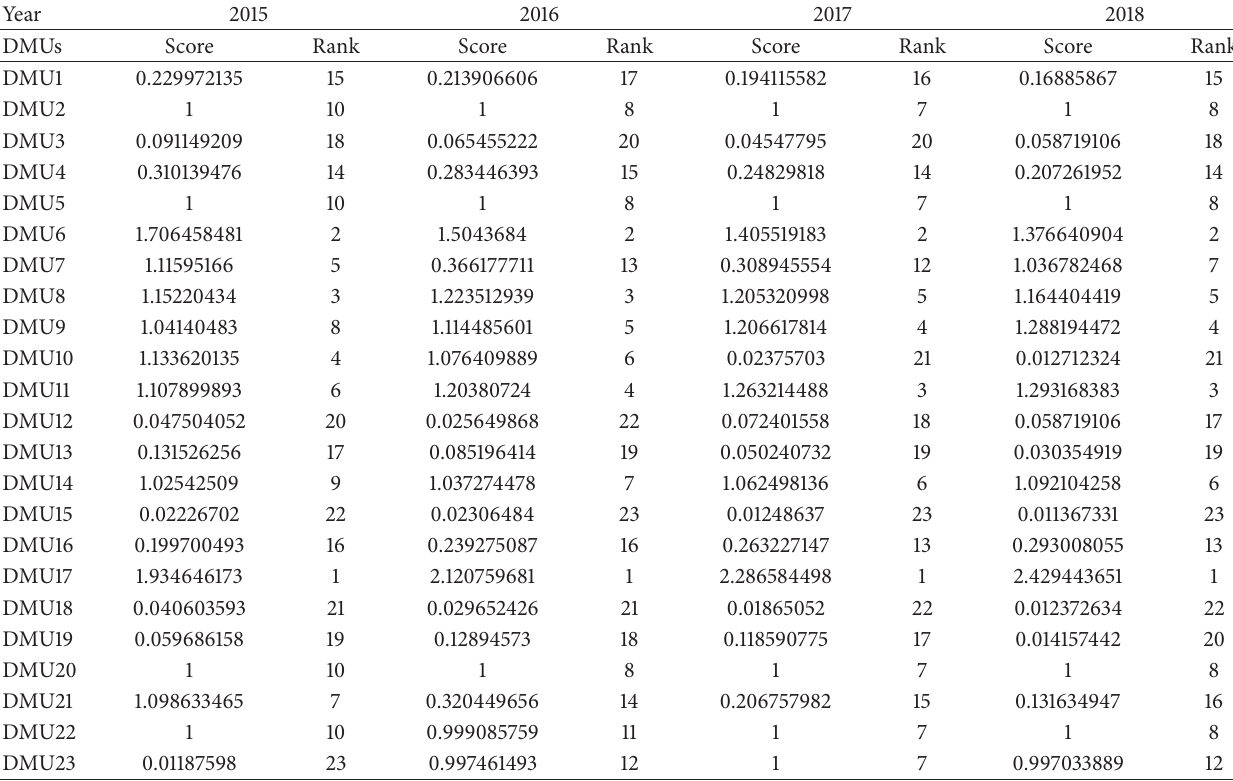
Table 9: Future scores and rankings of Indian mining